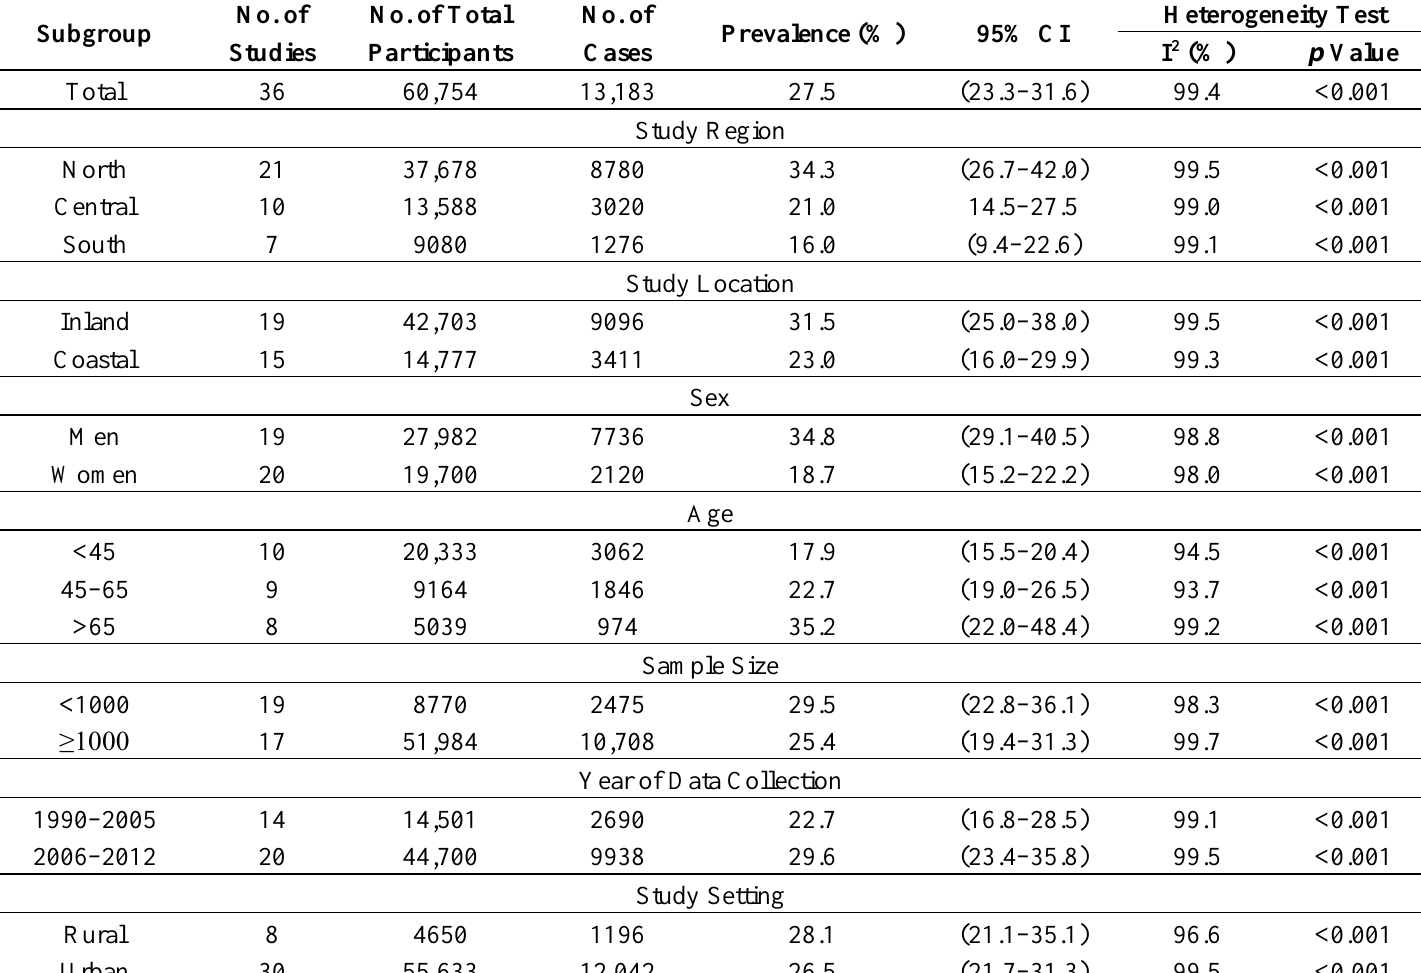
Table 1. Stratified meta-analyses of the prevalence of HHcy in